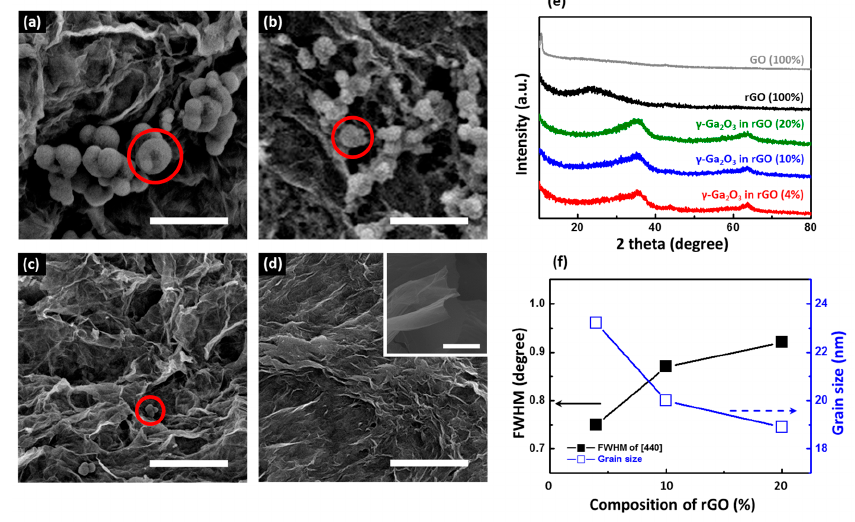
Figure 2. SEM images of HCs at ( a ) 4% rGO, ( b ) 10% rGO, ( c ) 20% rGO and ( d ) 100% rGO; scale bar is 1 μ m. For comparison, the SEM image of the GO is shown in the inset of ( d ); the scale bar is 10 μ m. The red circle indicates the presence of Ga 2 O 3 . ( e ) XRD spectra of different HCs (rGO ratio varies in the ranges of 4%, 10%, 20% and 100%). The GO exhibits a peak at 10.5° (indicating an interlayer spacing of 0.85 nm), revealing that the graphite has been completely oxidized via a modified Hummer’s method [19]. ( f ) Full-width at half-maximum (FWHM) variation for XRD peaks from ( e ), and grain size of the HCs as a function of the GO concentration in the